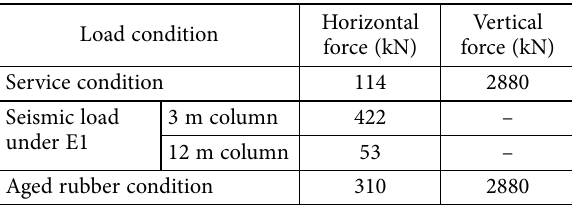
Table 1. Maximum forces applied to bridge column